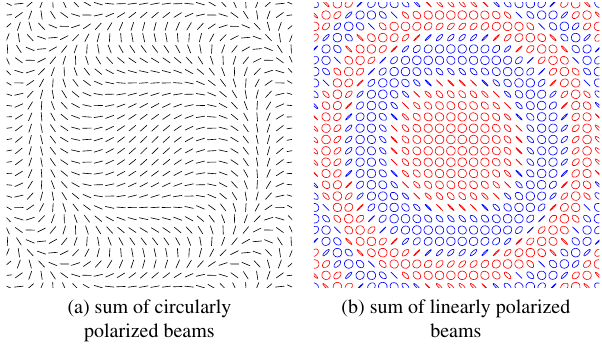
FIG. 5. Illustration of spatial polarization shaping: polarization ellipses at different transverse coordinates arcoss the sample for crossed helical (left plot) and planar (right plot) undulators. Color depicts radiation helicity, e.g., red corresponds to right-handed polarization and blue to the left-handed